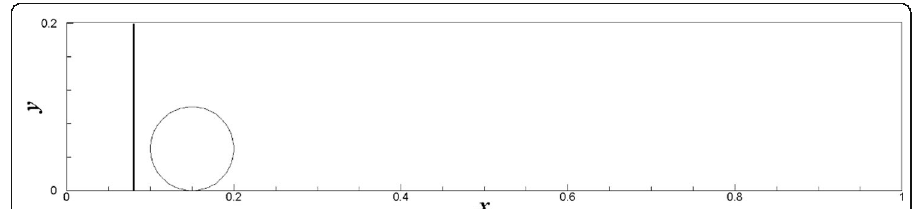
Fig. 10 Schematic diagram of cylinder